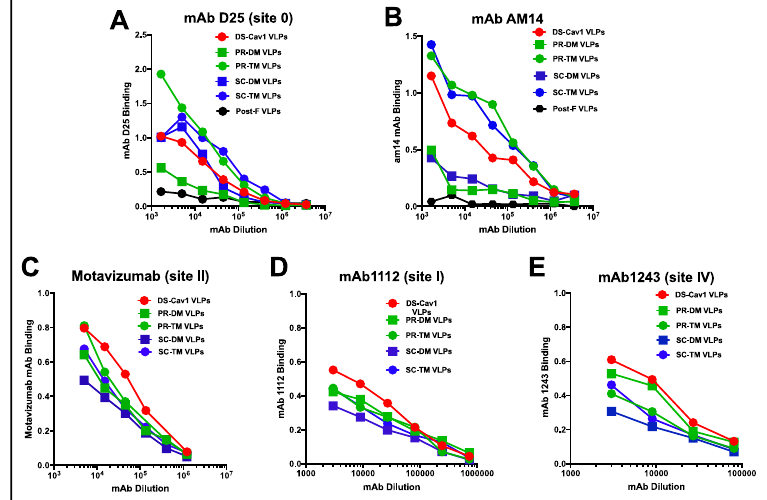
Figure 3. Relative binding of monoclonal antibodies to VLPs: Binding, measured as optical density, of decreasing amounts of pre-fusion F specific monoclonal antibodies to VLPs is shown in panels A (mAb D25, site 0) and B (mAb AM14, a trimer specific antibody). Binding to VLPs of mAb specific to sites common to both pre- and post-fusion F proteins are shown in panels C – E . Panel C: motavizumab (site II); Panel D: mAb 1112 (site I); Panel E: mAb 1243 (site IV). Equivalent amounts of F protein in